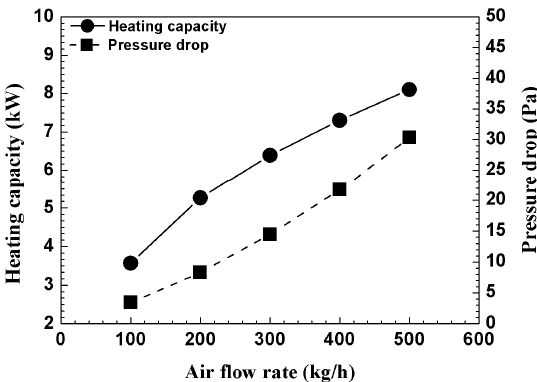
Figure 11. Variations in heating capacity and pressure drop for the L10 model (improved prototype).